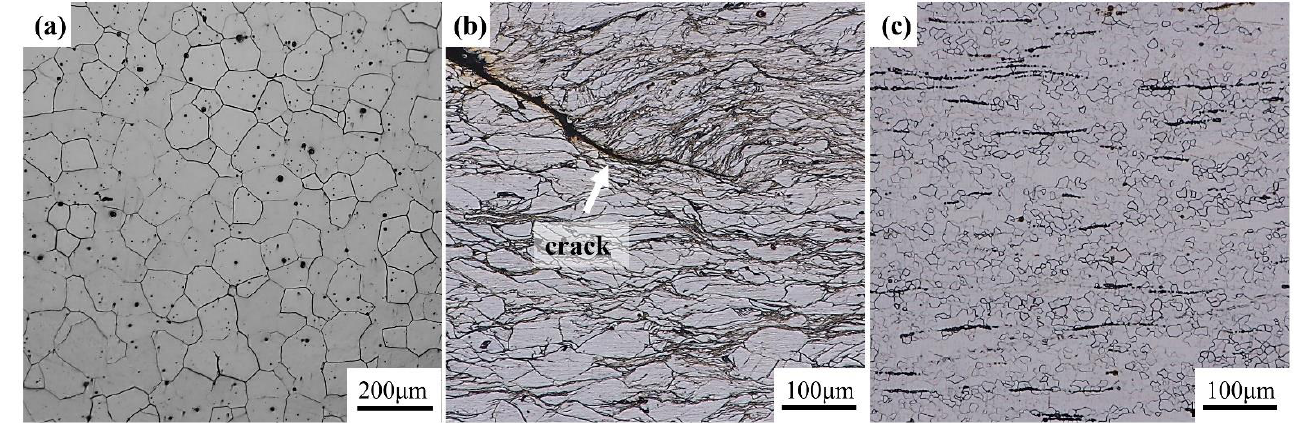
Figure 13. ( a ) initial as-solutioned state, ( b ) instability zone (300 °C/2 s −1 ), ( c ) maximum power dissipation zone (450 °C/0.02 s −1 ).